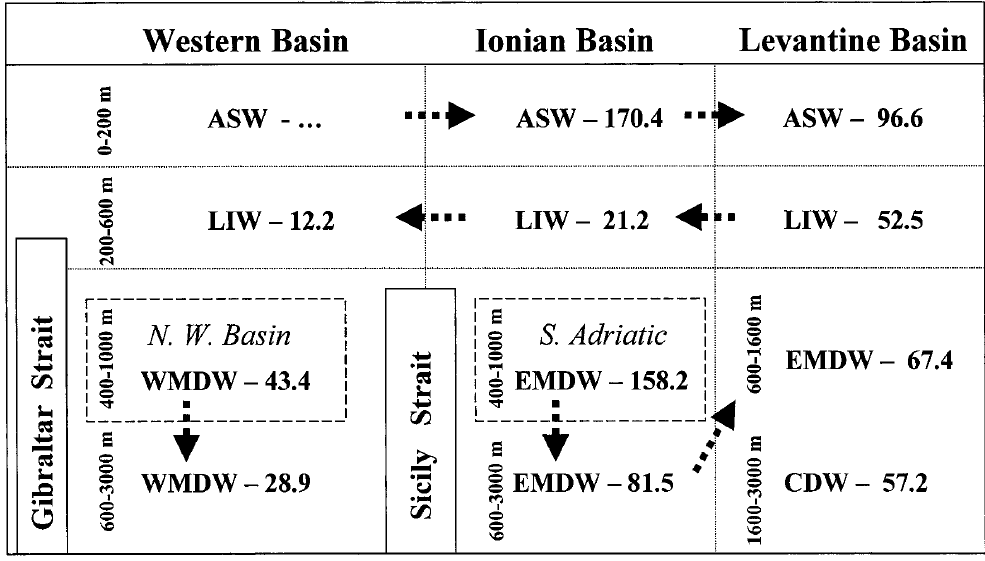
F IG . 3. – Schematic diagram summarising the coupling between CDPR (mg C m -2 d -1 ) and the main Mediterranean water masses. Arrows indi- cate the direction of the water mass flux between boxes. The main body of the Mediterranean Sea is divided into the Western, Ionian and Levantine basins. Two additional sub-systems, in the dashed line boxes, represent the deep (NW Mediterranean Basin and Southern Adriat- ic) water formation areas. Data are calculated from: Lefèvre et al . (1996) and Christensen et al . (1989) for Western Basin water mass; Azzaro et al . (1998) for Southern Adriatic; La Ferla et al . (1996) and La Ferla and Azzaro (2001) for Ionian and Levantine water mass. Modified from La Ferla and Azzaro